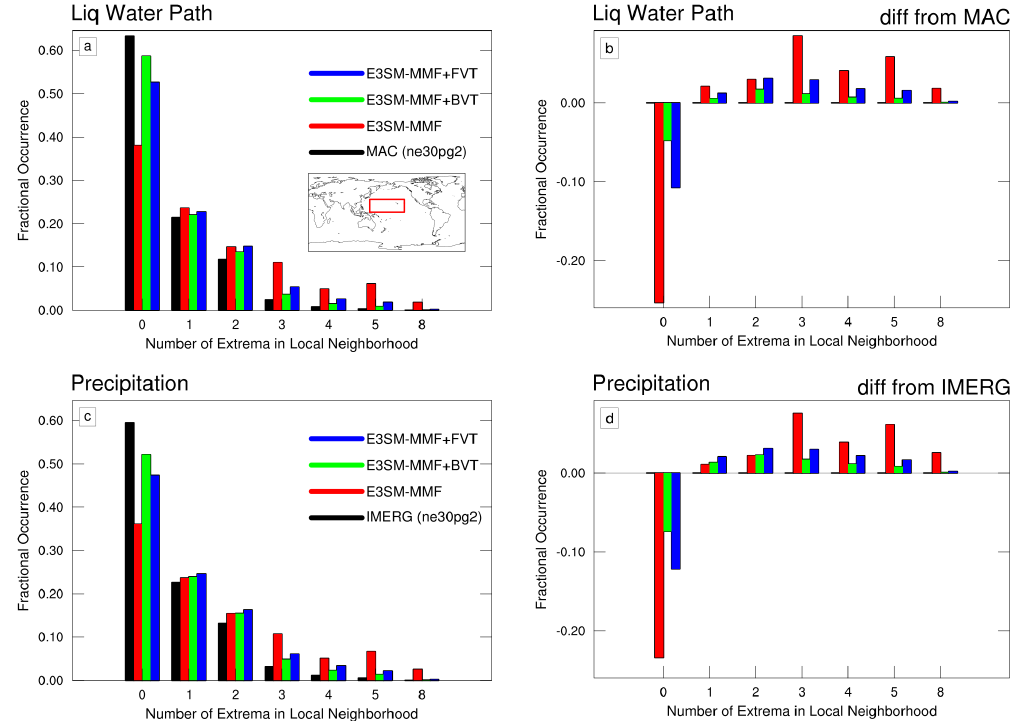
Figure 3. (a, c) Fractional occurrence of neighborhood patterns combined according to the number of local extrema (see text) over the region 0–30 ◦ N and 140–220 ◦ E (see inset map) for 10 years of satellite and E3SM-MMF data. Results for IMERG precipitation and MAC liquid water path were calculated from data regridded to the ne30pg2 grid used by the model for direct comparison. (b, d) Difference of fractional occurrence relative to satellite